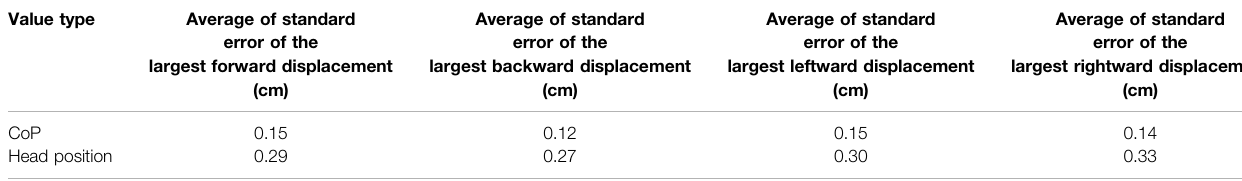
TABLE 5 | Average of standard error of the largest displacement of CoP and head position in each